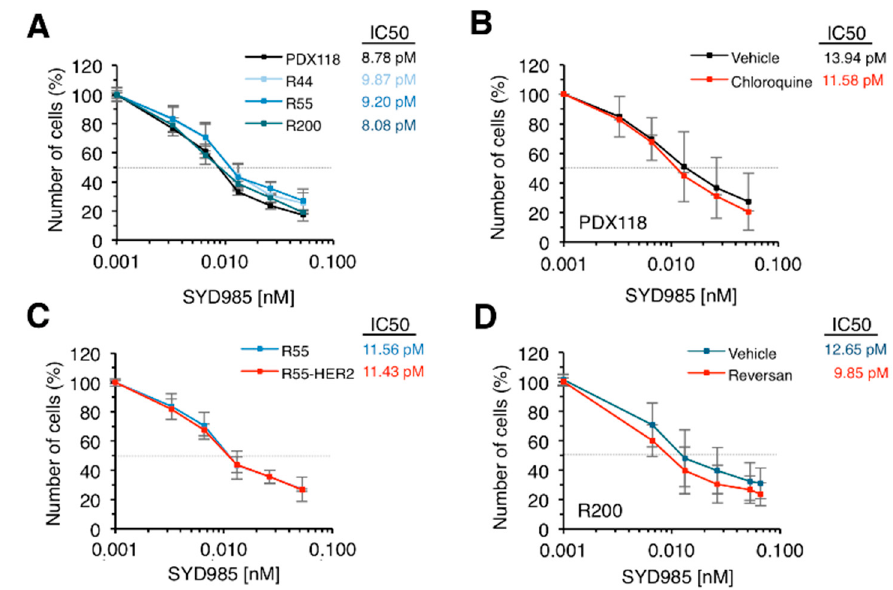
Figure 4. Effect of SYD985 on in vitro resistant models. ( A ) The indicated cell cultures were treated with increasing concentrations of SYD985 for 6 days. Cell numbers were estimated by crystal violet staining. Dashed grey line indicates 50% survival and IC 50 is shown next to figure legend. Averages and standard deviation of six independent experiments are represented; ( B ) Cultures from PDX118 were treated with vehicle or chloroquine and with increasing concentrations of SYD985. Cell numbers were analyzed as in A; ( C ) The indicated cells were treated and analyzed as in A; ( D ) R200 cells were treated with vehicle or Reversan and with increasing concentrations of SYD985. Cell numbers were analyzed as in A.